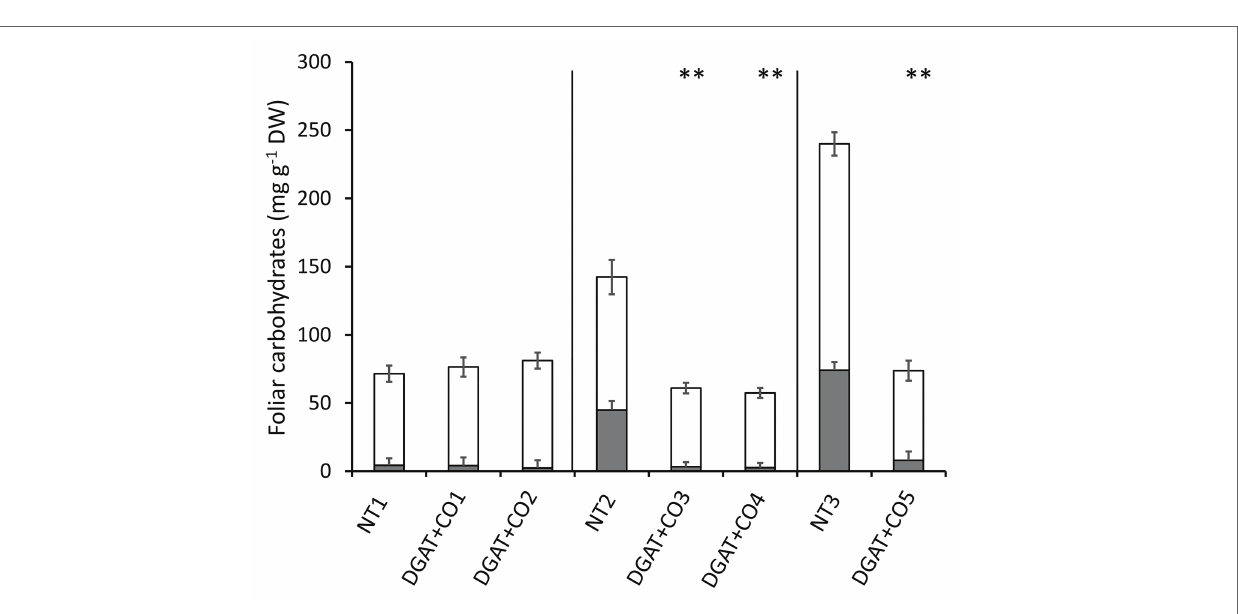
Means ± SE. ** indicates statistically significant difference from respective NT control (p < 0.01). n = 10. Lines with matching genetic backgrounds are grouped together.